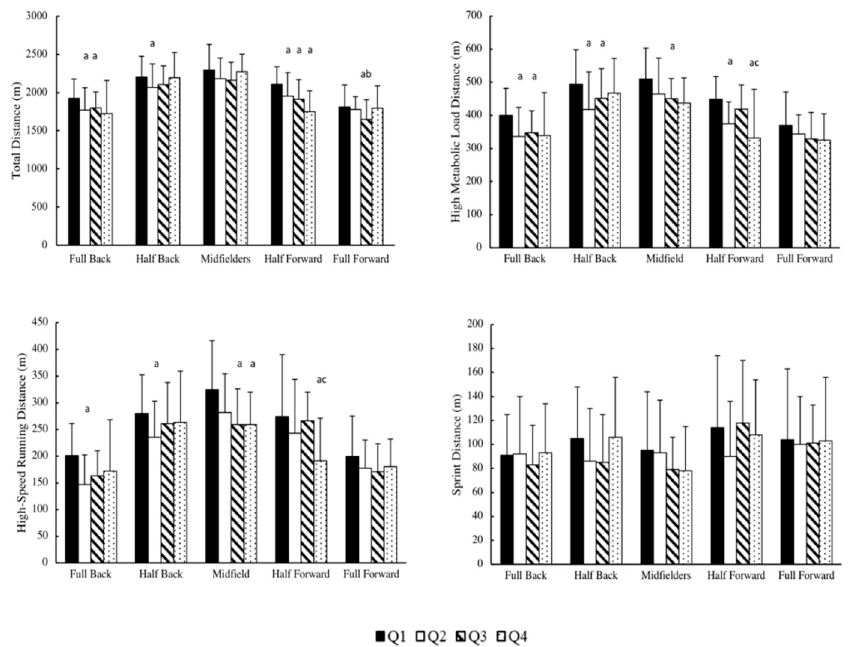
Figure 2. Mean ± SD total-, high-speed running-, sprint-, and high metabolic load-distance covered per quarter per position is shown. Q = quarter, a = different ( p < 0.05) from quarter 1, b = different ( p < 0.05) from quarter 2, c = different ( p < 0.05) from quarter 3.